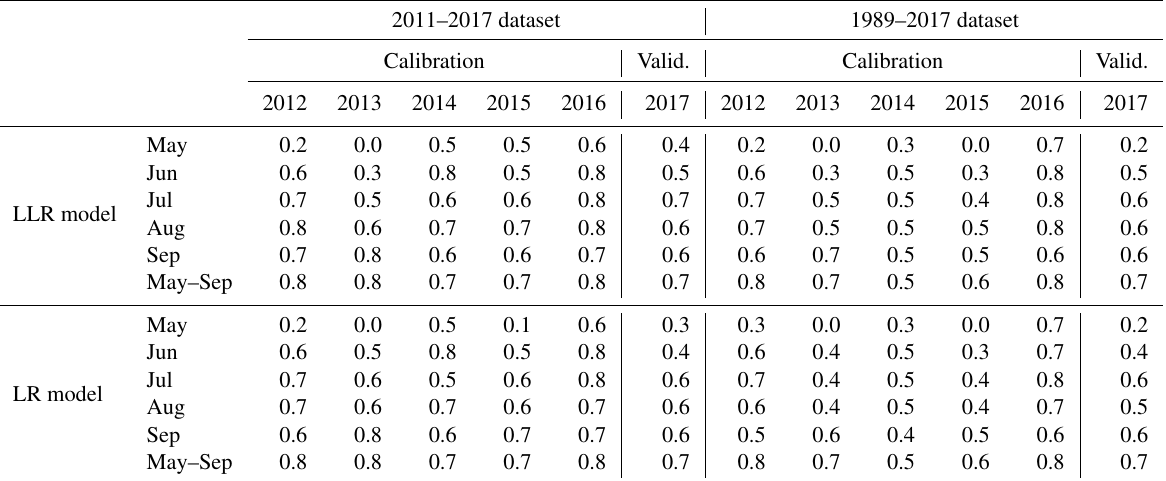
Calibration Valid. Calibration